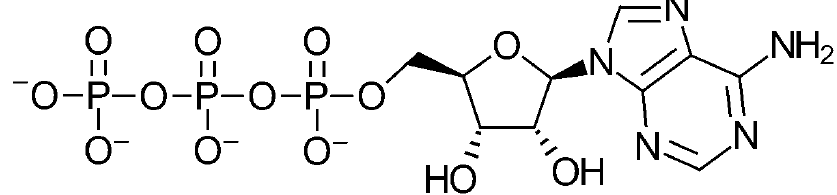
Figure 11. Adenosine triphosphate (ATP) is a combination of one adenine, one ribose and three phosphate groups.